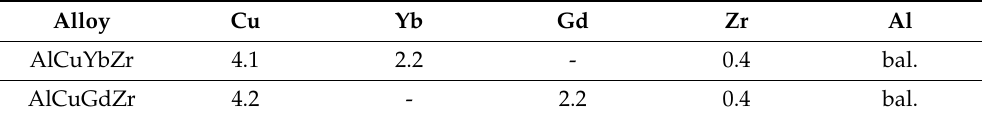
Table 1. Chemical composition of the alloys, wt %.